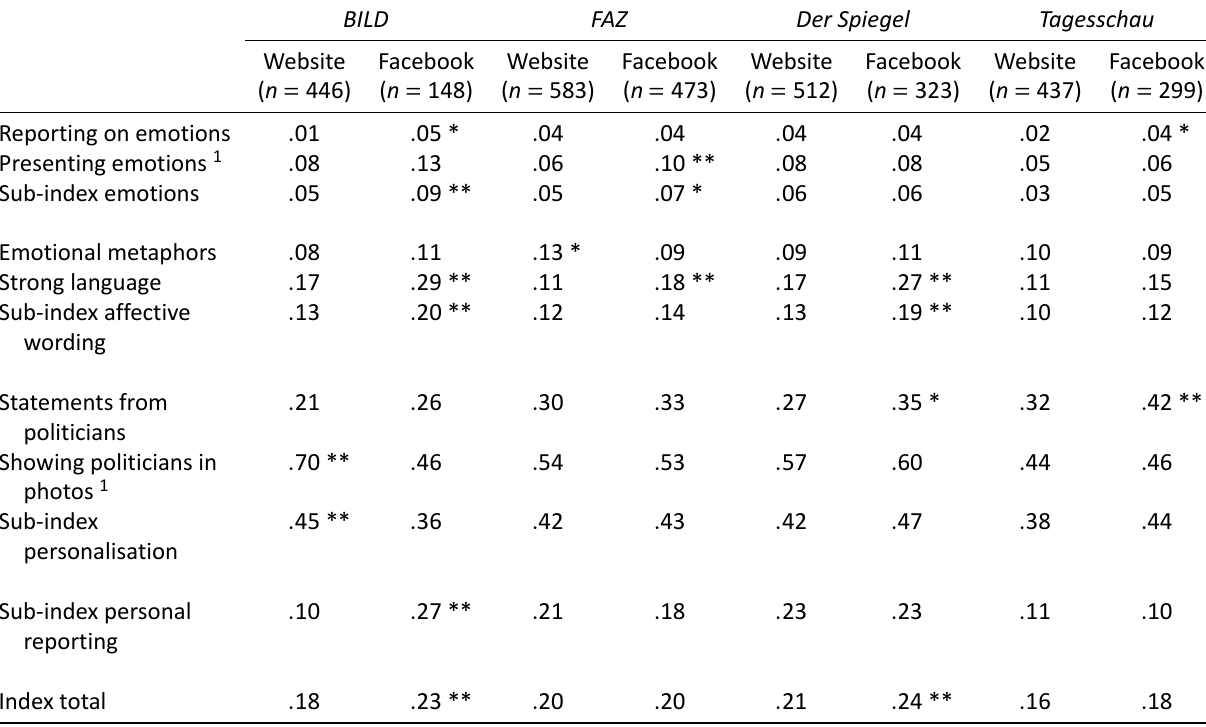
Table 3. Comparison of website teasers and Facebook posts regarding news